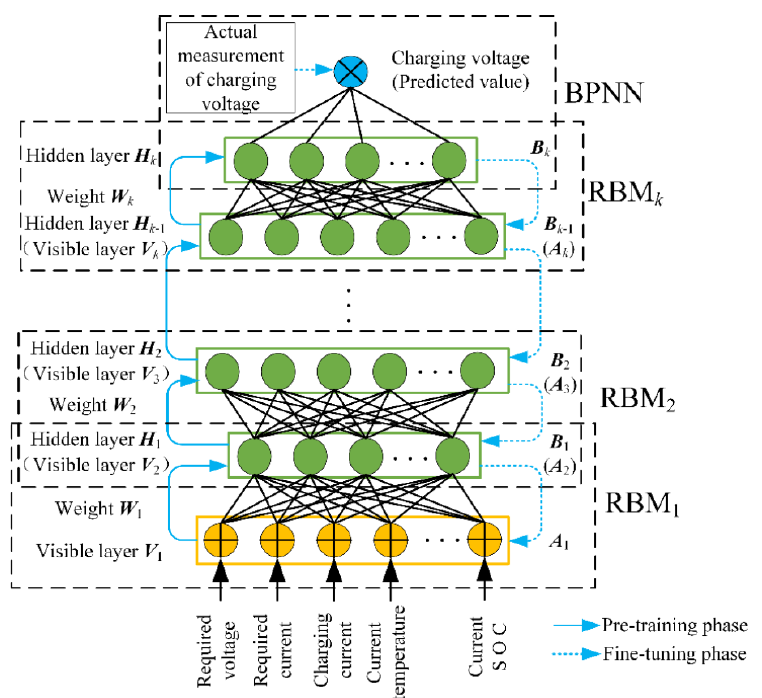
Figure 2. Structure and training diagram of deep belief network (DBN) model for normal charging